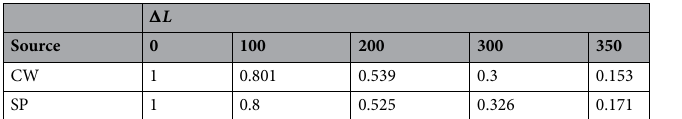
Table 1. Measured visibilities for Fig. 4. (cid:31) L unit: µ m . CW continuous wave laser light at 200 µ W . SP single photon.